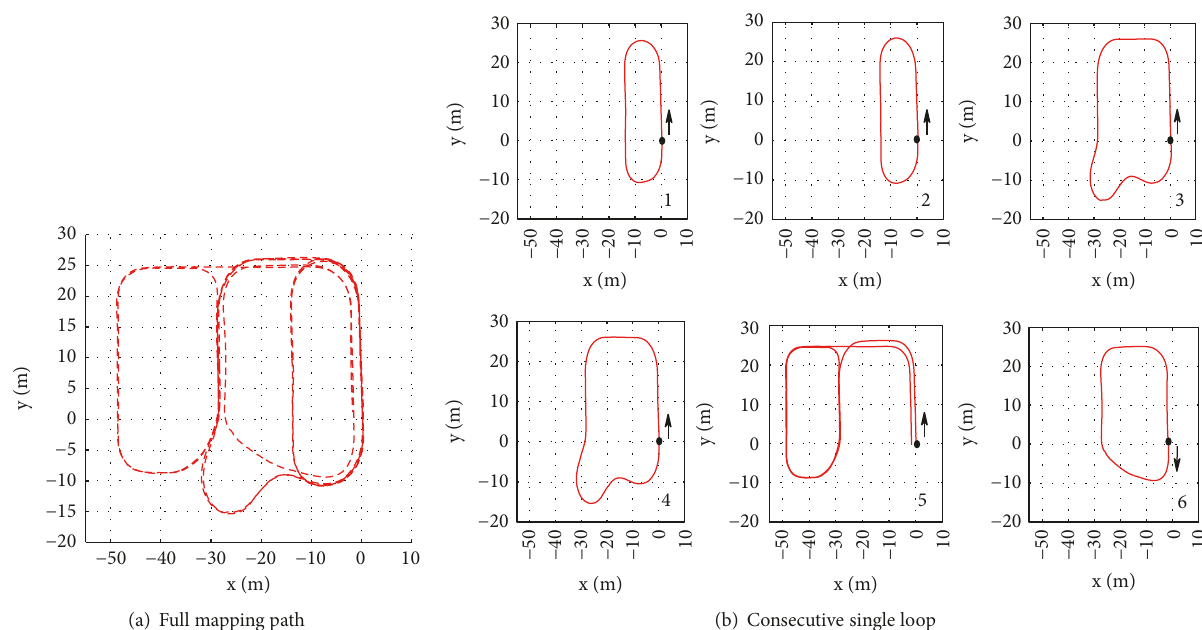
Figure 12: The reference path (RTK-GPS) of mapping sequence.